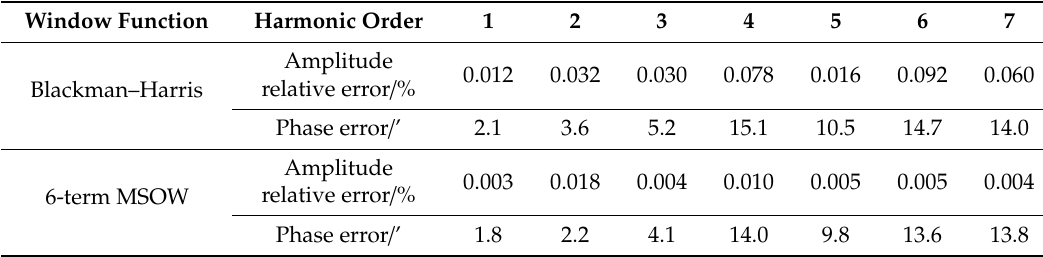
Table 7. Experiment measurement